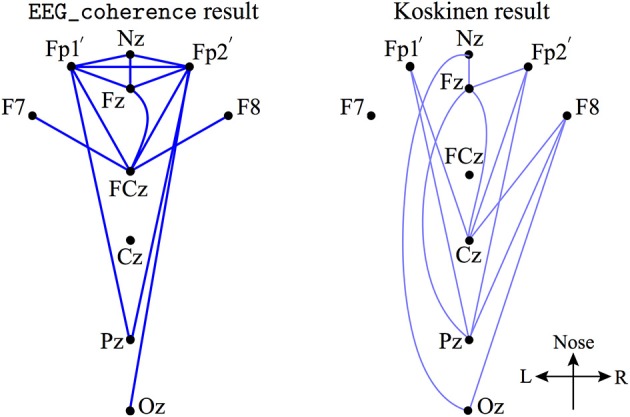
A subset of electrode-pairs (left) showing significant (p < 0.05) reduction in phase coherence extracted from the upper left corner plot of Figure 4 (referenced to Cz, in dark blue lines) and Koskinen et al. reported pattern (Koskinen et al., 2001) (right, referenced to FCz, in light blue lines) for the coherence measured from 9 electrodes: Nz (nasion), Fp1′(about 1 cm down from Fp1, just above the eyebrow), Fp2′, Fz, F7, F8, Cz, Pz, and Oz.